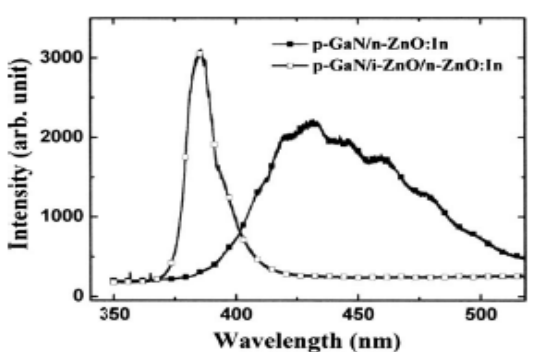
Figure 21. The room-temperature EL spectra of the p - n and p - i - n . Reprinted from Ref. [39] with